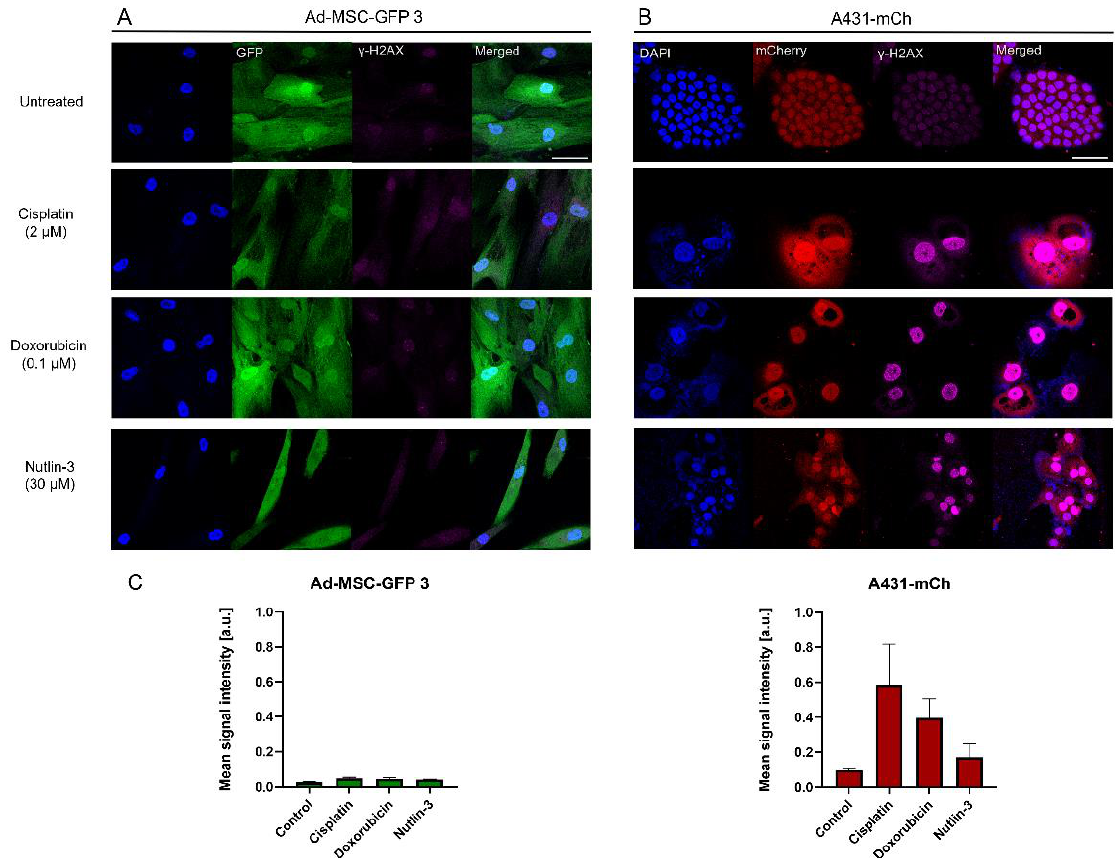
Figure 3. Analysis of DNA double-stranded breaks in ( A ) Ad-MSC-GFP 3 and ( B ) A431-mCh cell lines at 120 h, treated with IC 50 concentrations of A431 cells with γ -H2AX intensity quantification ( C ). Scale bar on the confocal images is 50 µM.